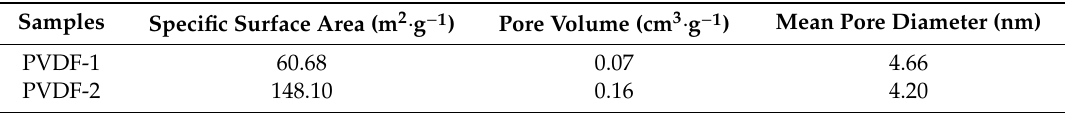
Table 2. The Brunauer–Emmett–Teller (BET) specific surface area, total pore volume, and mean pore diameter of PVDF electrospun fiber membranes.